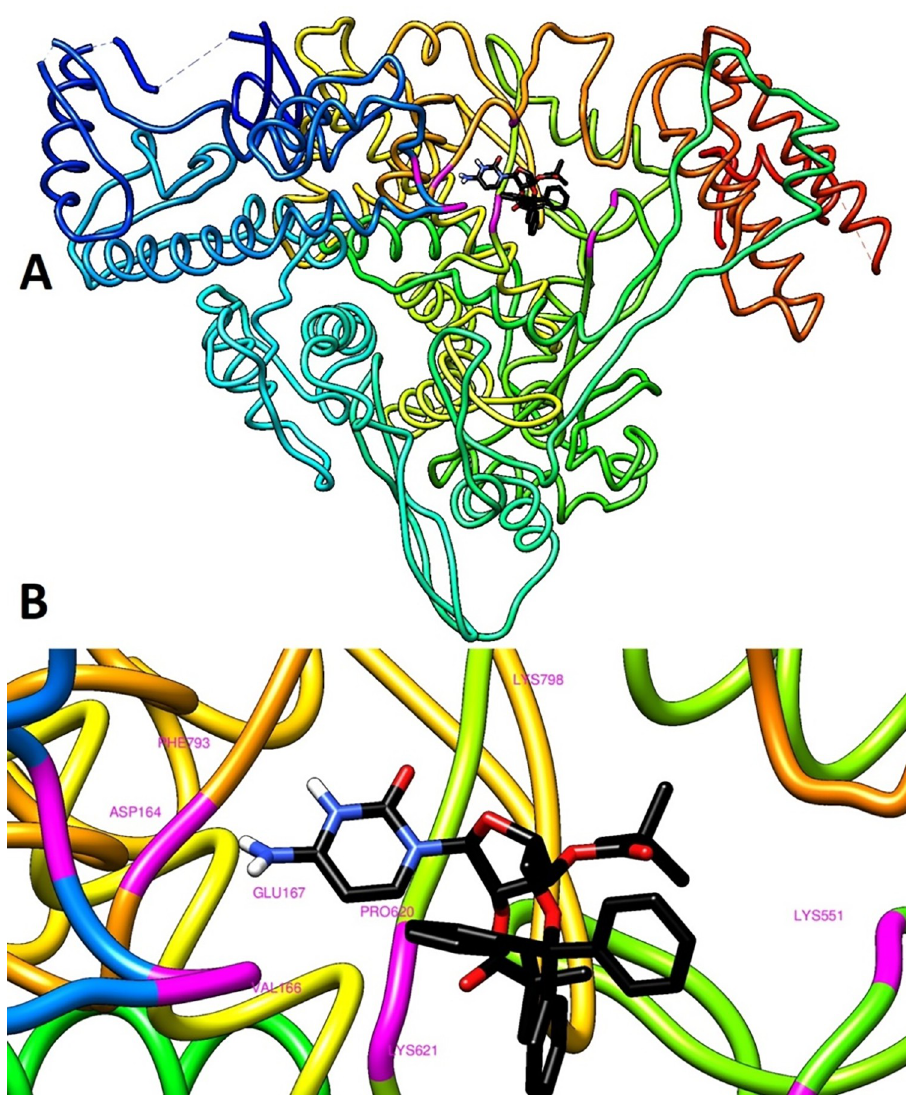
Fig 6. ( A ) Docked 3D pose. Derivative 13 with RdRp (PDB: 6M71). ( B ) The close viewer of key active site residues involved in interactions with derivative 13